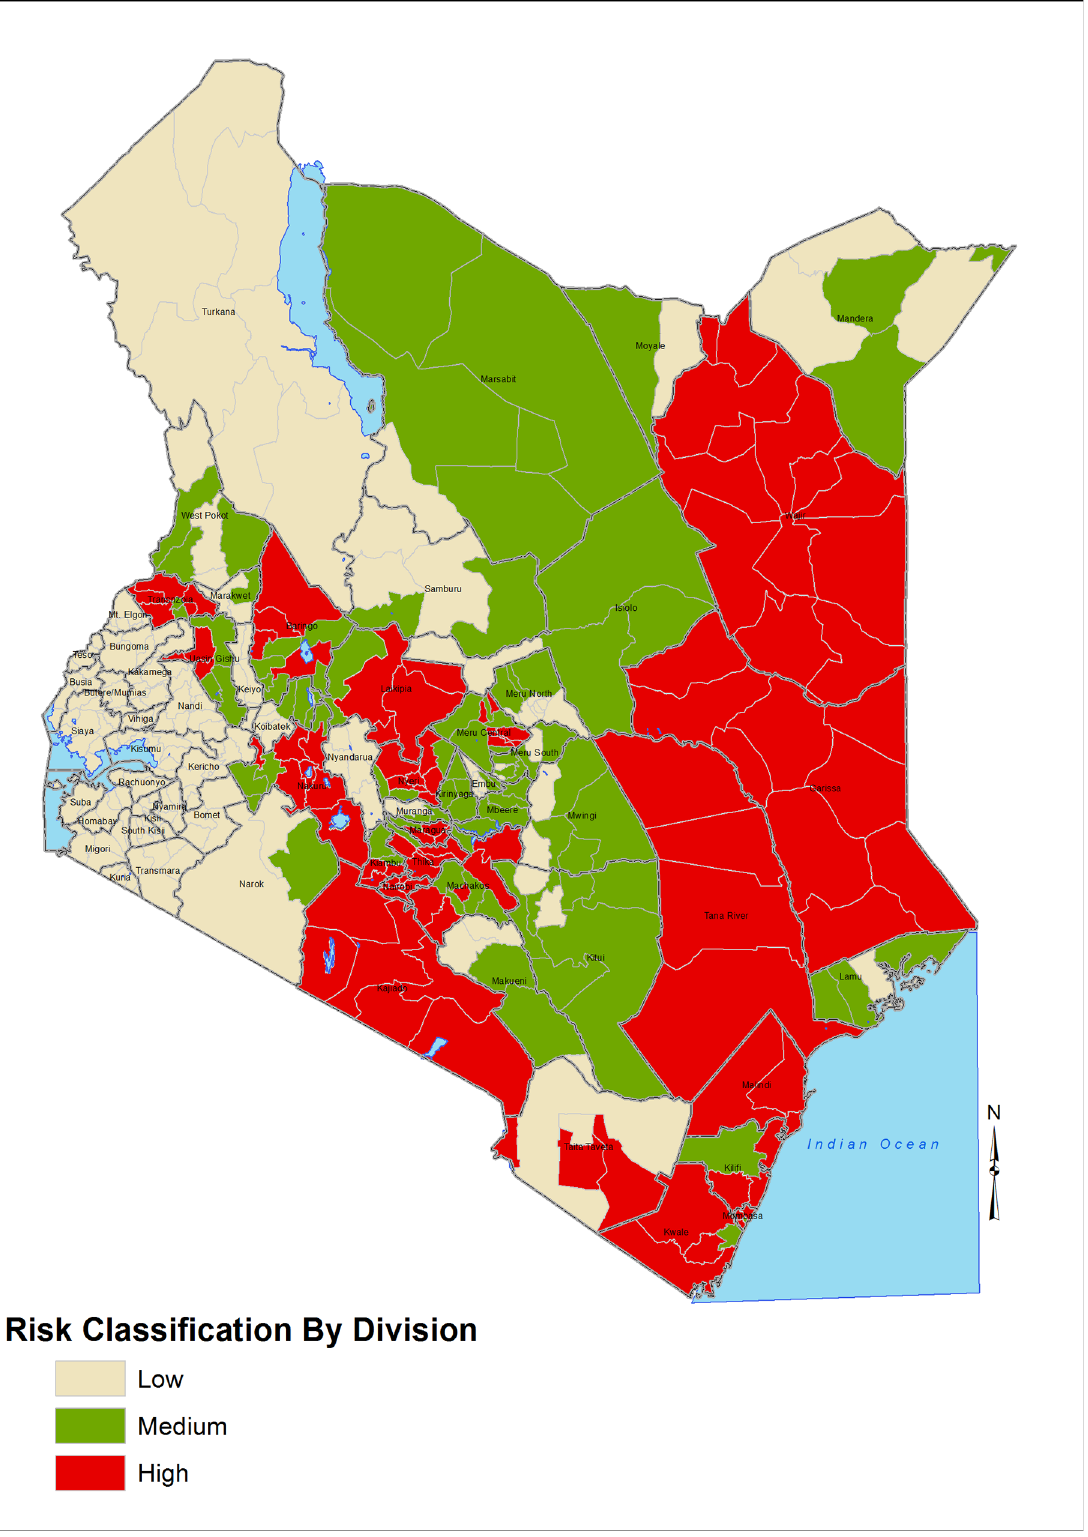
Fig 1. Rift Valley Fever risk map for Kenya, 2012 based on the semi-quantitative risk assessment for likelihood of RVF epizootic and expert opinion.